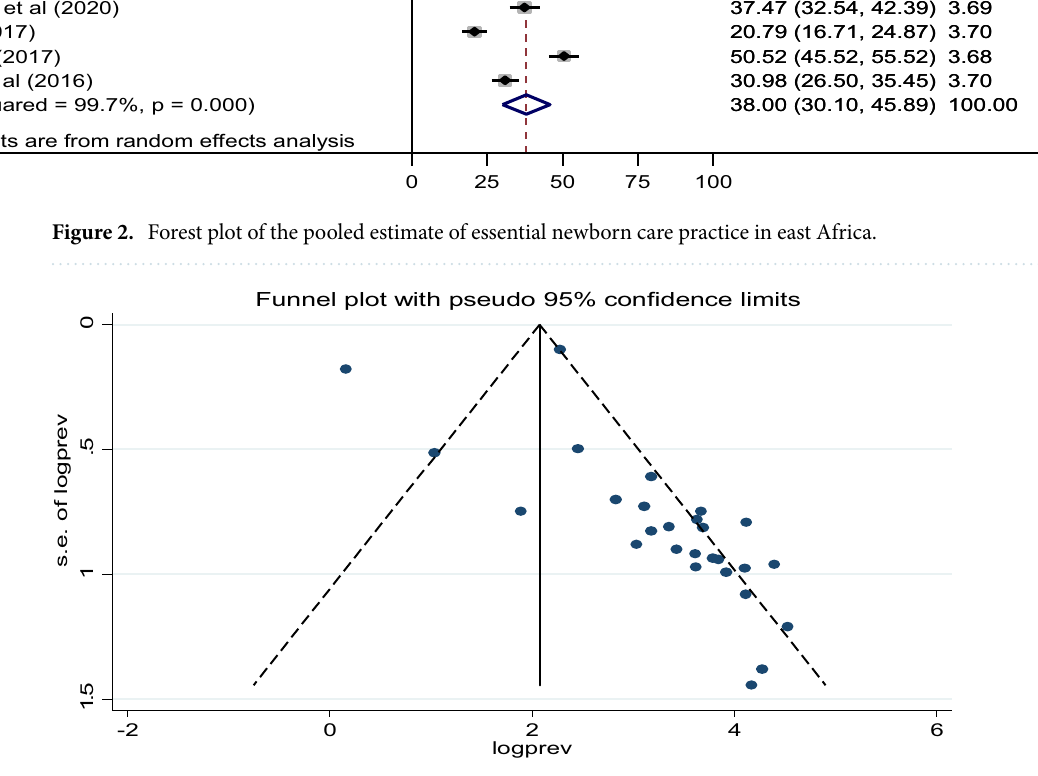
Effect of antenatal care follow up on essential newborn care practice. We included a total of 6 cross- sectional studies to estimate the effect of ANC follow up on essential newborn care practice in east Africa. The participants of the studies ranged from 417 to 834 (Table 2). The included studies showed significant hetero- geneity and detected using I 2 statistic (I 2 = 74.0%, P value = 0.002) (Fig. 4). Therefore, a random effect model was used to estimate the overall pooled effect of ANC follow up on essential newborn care in the study area.